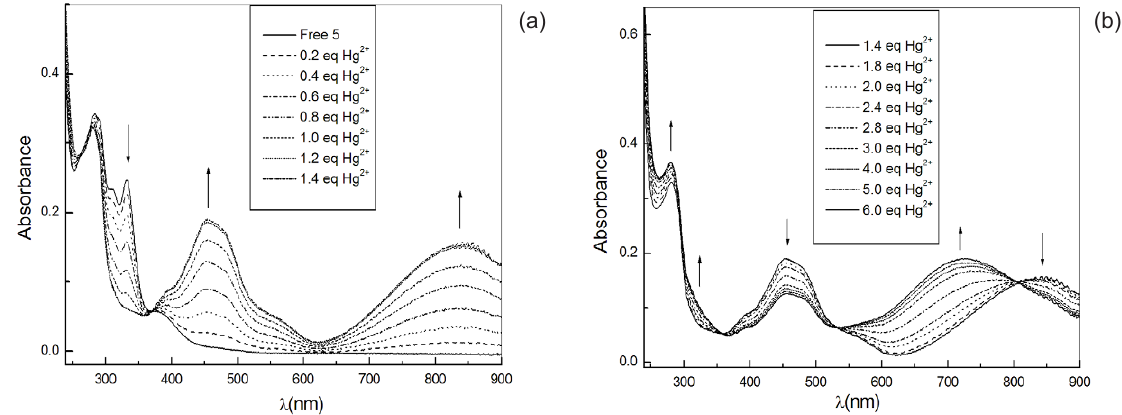
Figure 5. Absorption spectra of 5 (1.0×10 -5 M in CH (a); 1.4~6.0 equiv.